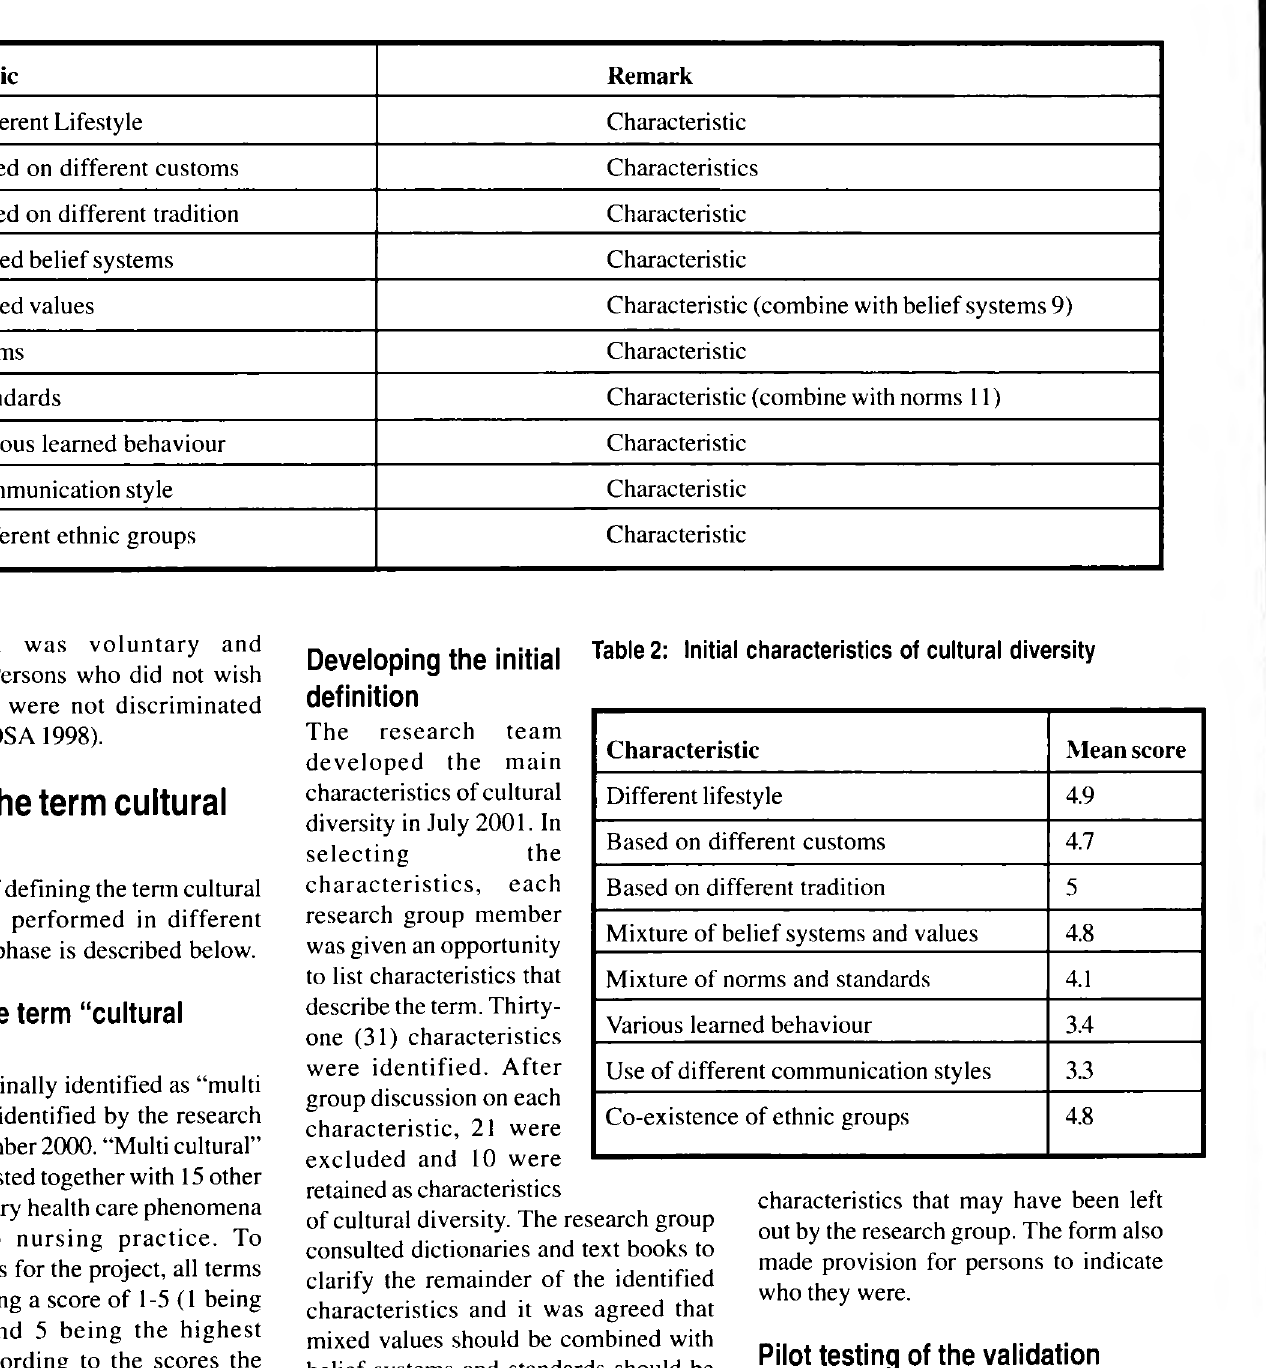
Table 1 Characteristics of cultural diversity identified for voting